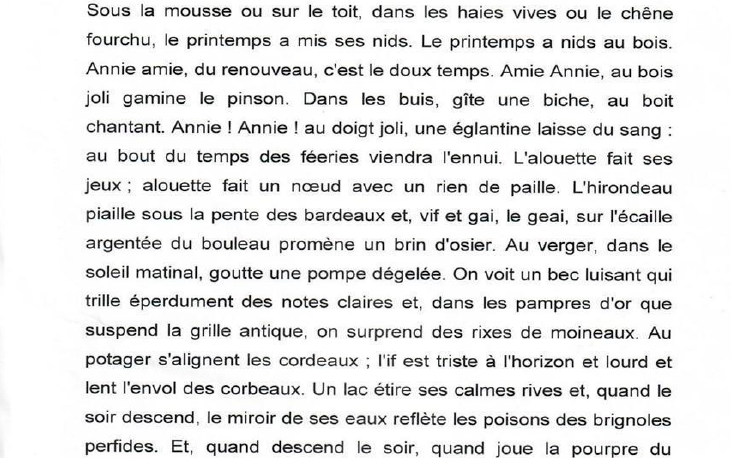
Figure A1. L’Alouette Text.